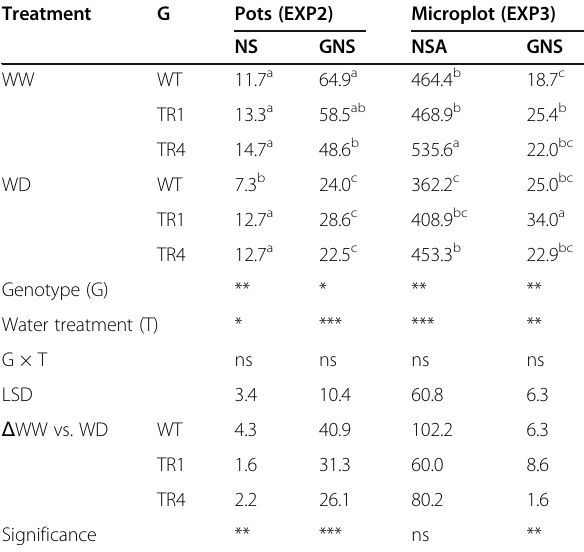
Table 4 Primary subcomponents of the grain number in EXP 2 and EXP3 under greenhouse conditions